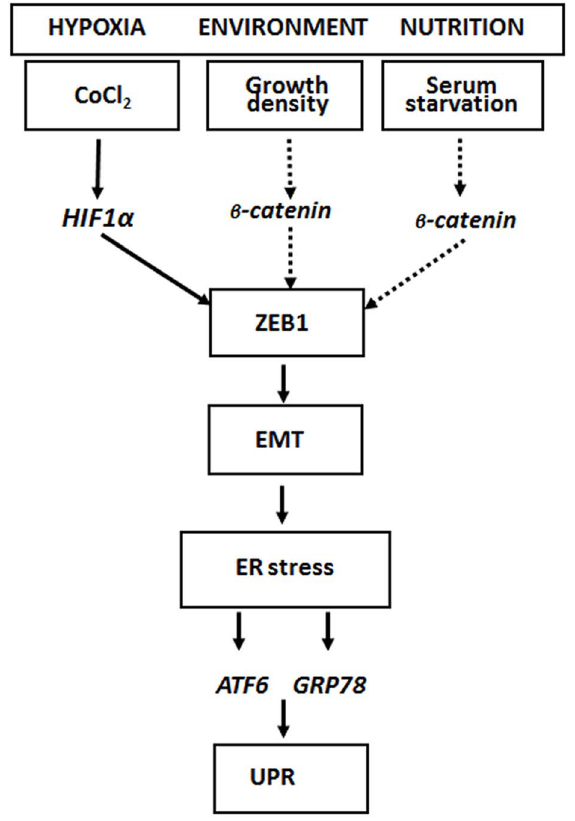
Figure 5. Model for the relationship between EMT and ER- stress. At the invasive front of CRCs cellular stress, like hypoxia or changes in the microenvironment, induces either the EMT regulator ZEB1 via HIF1 [1,4] or potentially nuclear translocation of b -catenin [2,4]. ZEB1 induces EMT which represents the driving force for ER-stress and UPR induction due to GRP78.